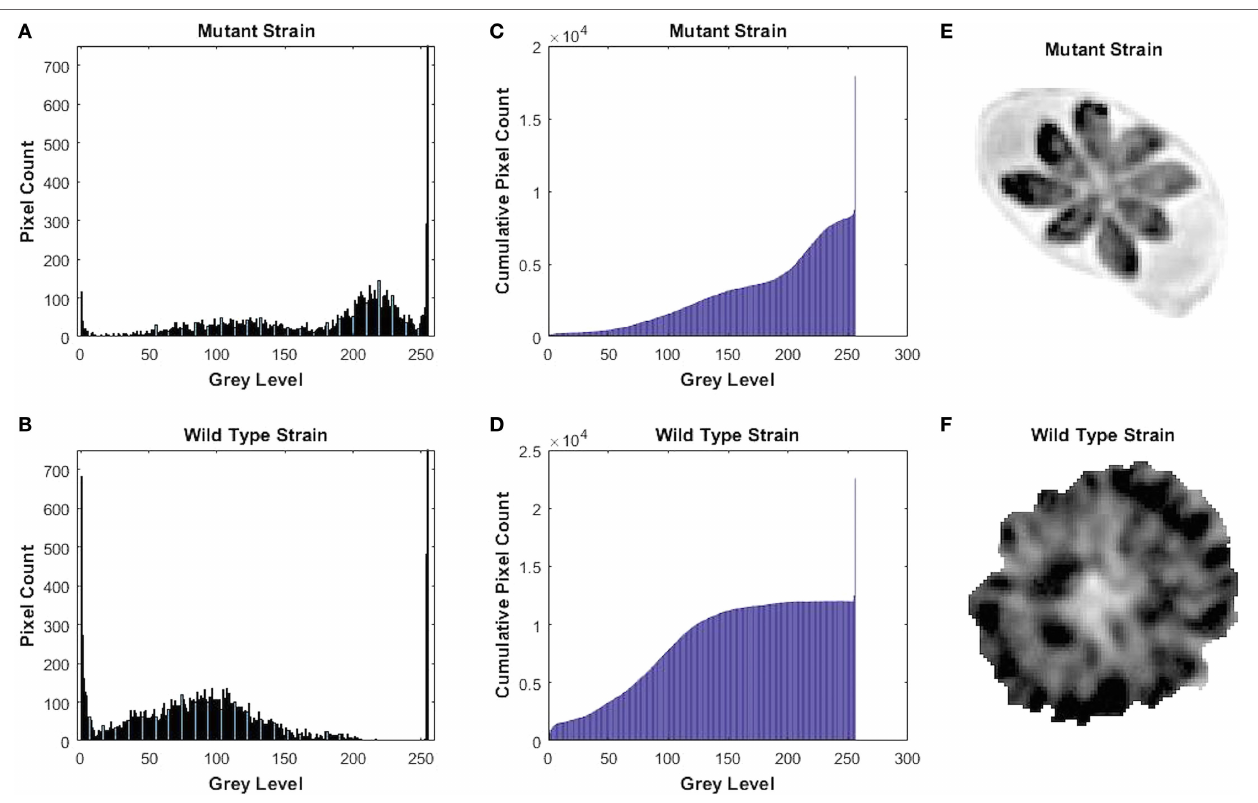
FigUre 3 | Gray-level histogram for mutant and wild-type Toxoplasma gondii strains. (a,B) show the number of pixels in each gray level (0–256) of the images of the parasitophorous vacuole (PV) with 0 signifying black and 256 signifying white. (c,D) show the cumulative pixel count for the same images, which are shown in (e,F) . This shows that PV produced by wild-type strain had a significantly larger fraction of darker pixels, which represents the large number of the growing intra-vacuolar parasites, whereas the PV of mutant strain had significantly lower quantity of the intra-vacuolar parasites, as shown by a greater proportion of the ligher